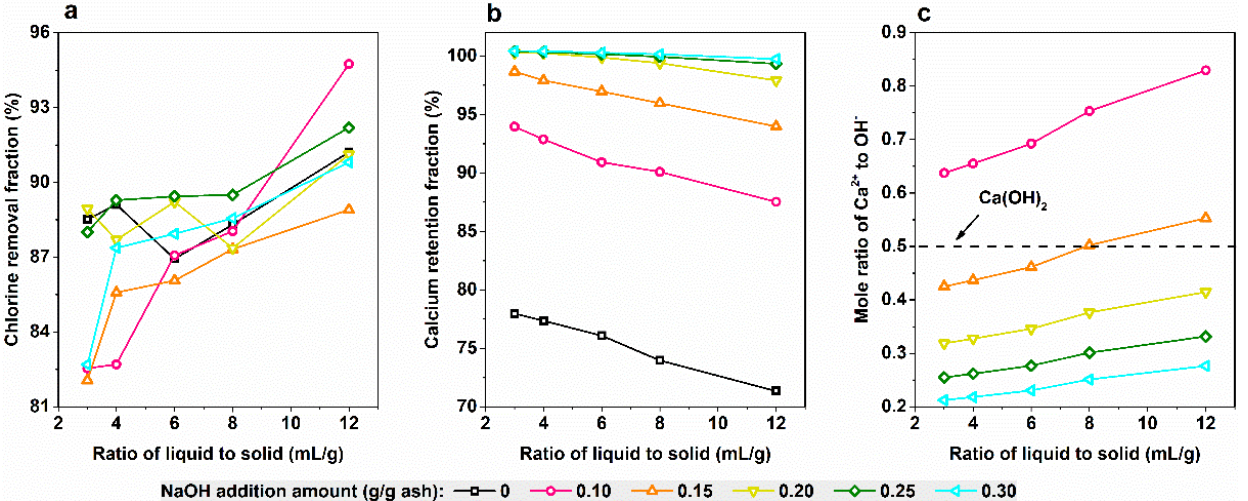
Figure 4. The fractions of chlorine removal ( a ) and calcium retention ( b ) after washing with various mole ratios of Ca 2+ /OH − ( c ).